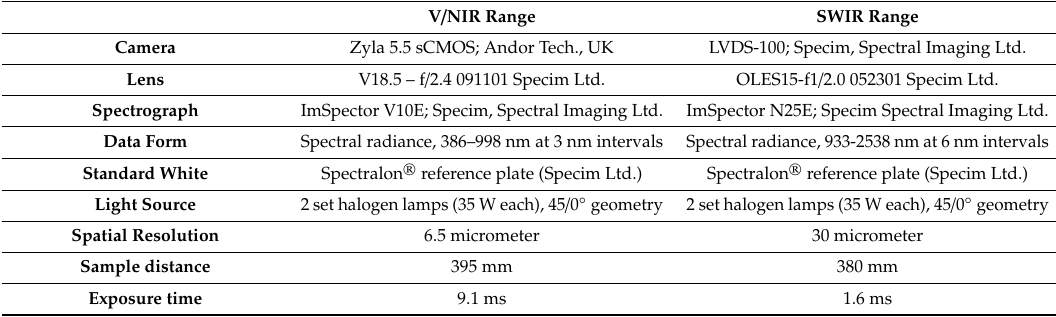
Table 1. Measurement specifications of the spectral camera